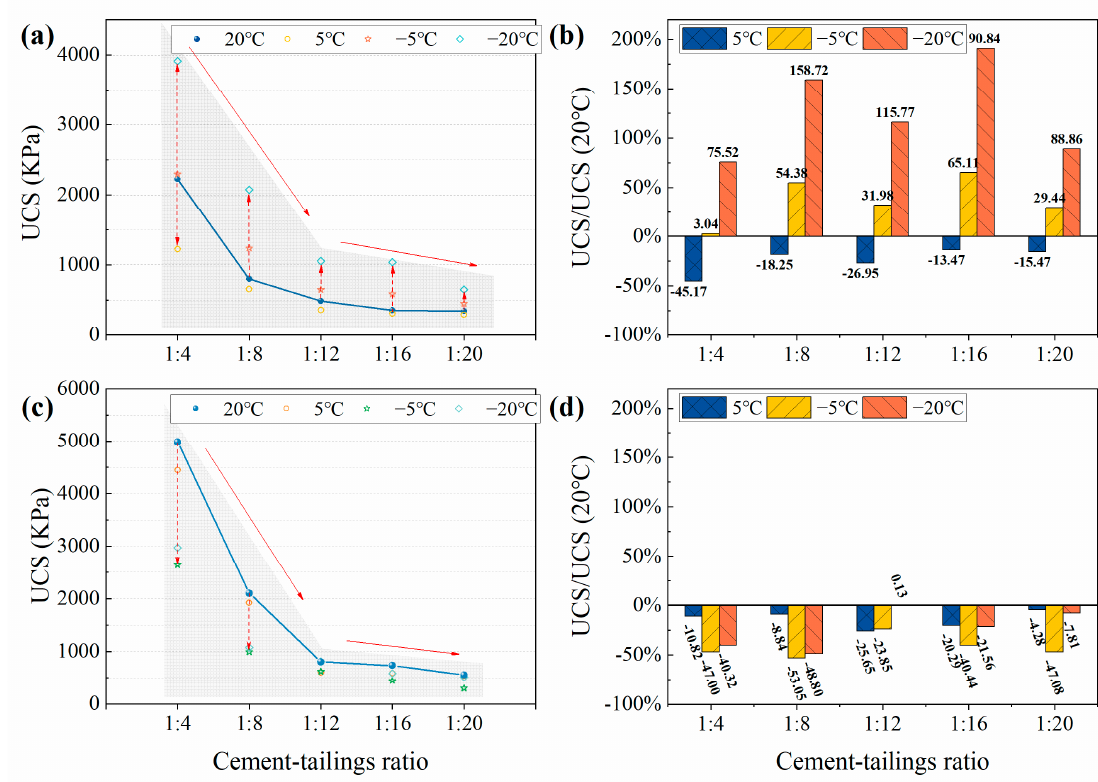
Figure 5. The relationship between CTR and the UCS of CTB at different curing temperatures and the strength change compared with curing at 20 ◦ C, ( a , b ) 3 days, ( c , d ) 28 days. At 3 days, the UCS of CTB reduced at 5 ◦ C versus 20 ◦ C curing conditions. When